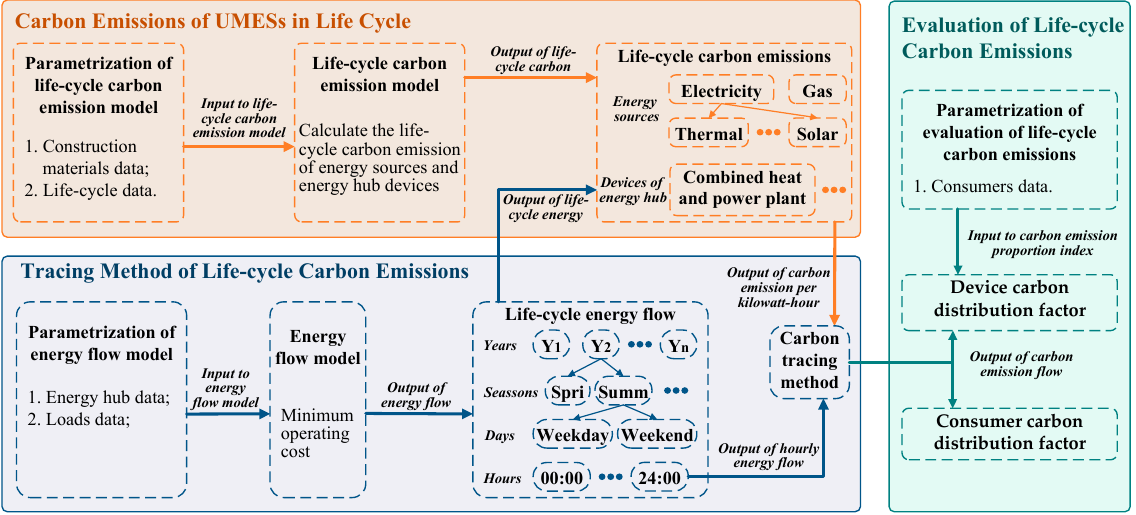
Figure 3. Flowchart of carbon emission evaluation of UMESs.